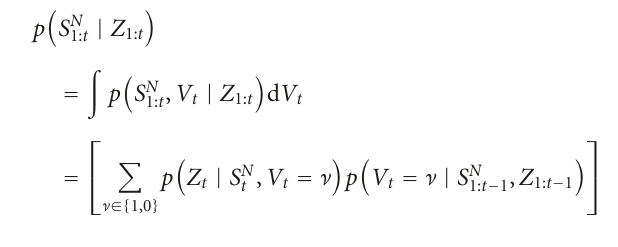
Figure 10: The RBPF and windowed ML search method require similar computational time per number of likelihood evaluations. However, the RBPF can work with as few as 200 particles; whereas the windowed ML search method requires more than 400 points. The dotted line denotes tracking failure. (The times were calculated by running the respective Matlab implementations on a dual core 2.4GHz Windows machine and averaging over 10